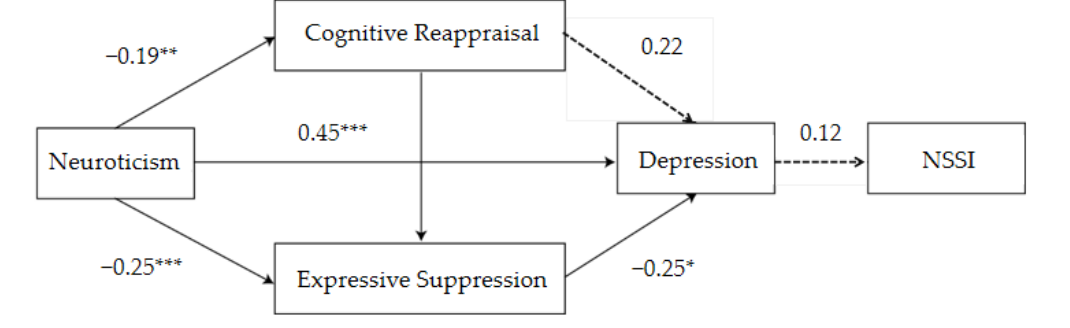
Figure 2. Influence of neuroticism on NSSI behavior: schematic diagram of the mediating role of emotion regulation and depression among male college students. * p < 0.05, ** p < 0.01, *** p < 0.001.